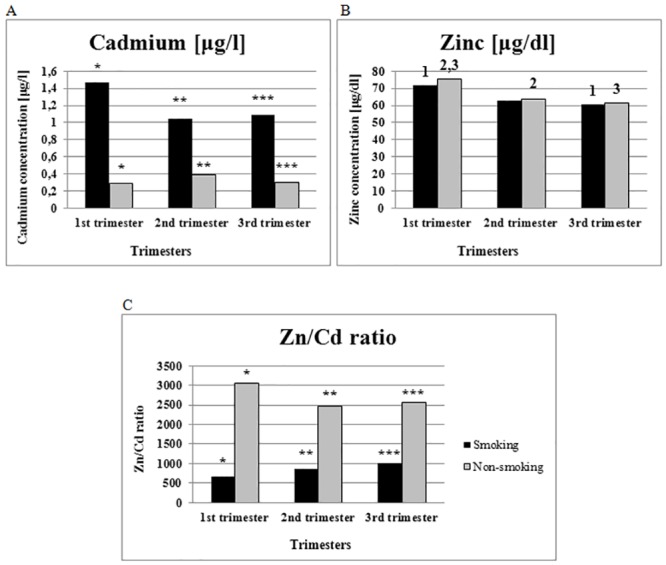
Metals concentration (A—cadmium; B—zinc) and Zn/Cd ratio (C) in smoking and non-smoking women during pregnancy.1, 2,3
significant (p < 0.04) for the Zn in the same group to the other trimester (e.g. 1S group in the 1st trimester has higher level of Zn than in the 3rd trimester). *-*** significant (p < 0.02) for the same parameter in the same trimester for different smoking group (e.g. *S group in the 1st trimester has higher level of Cd than NS group in the same trimester).